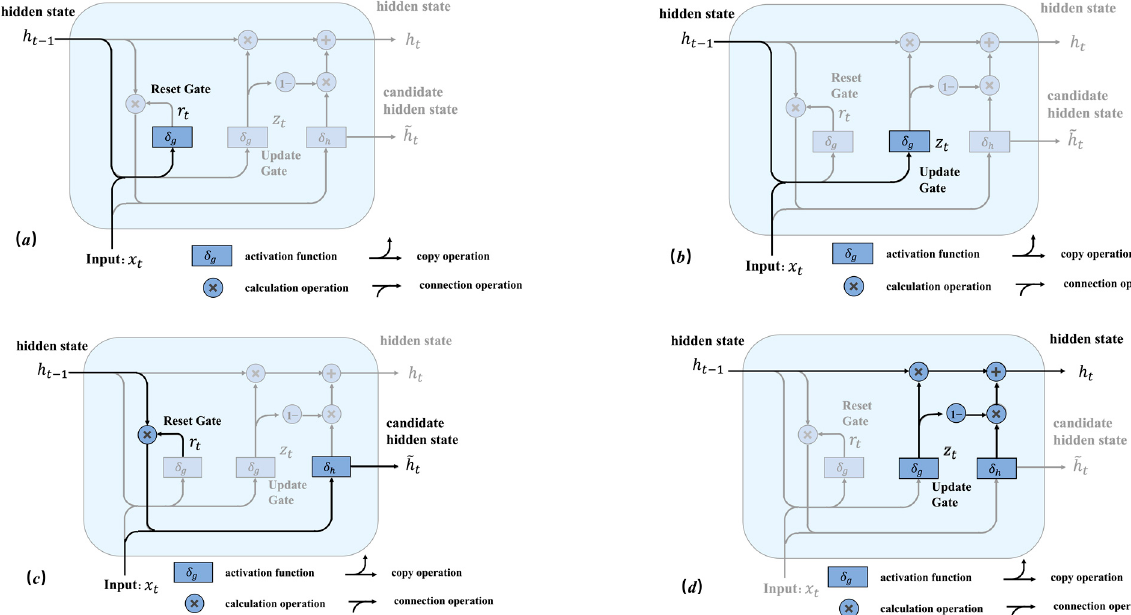
Figure 3. The calculation process of GRU: ( a ) calculation of reset gate; ( b ) calculation of update gate; ( c ) calculation of candidate hidden state; ( d ) calculation of hidden state.